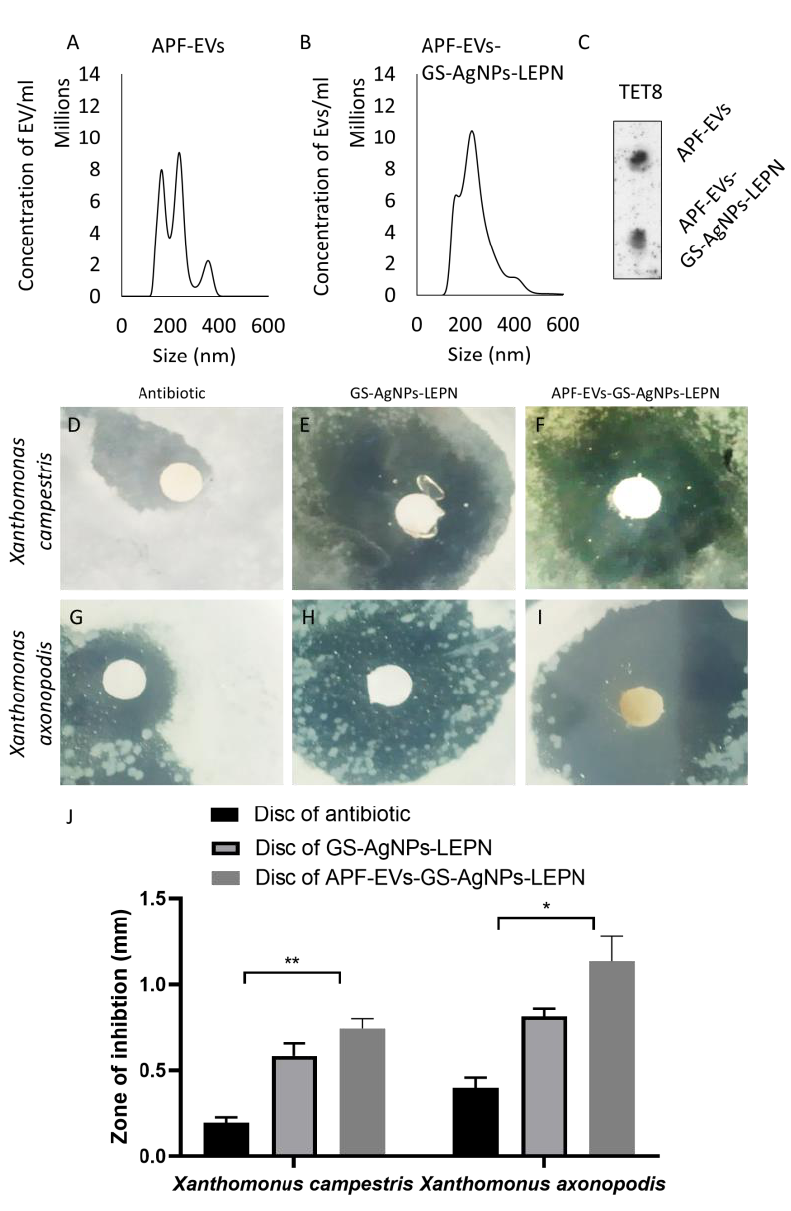
Figure 6. Comparing the antimicrobial activity of APF-EV-GS-AgNP-LEPN and GS-AgNP-LEPN against two different Xanthomonas species by a disc diffusion test. Representative ( A , B ) size distribution and ( C ) immunoblot showing the expression of TET8 in protein samples of APF-EV and APF-EV-GS-AgNP-LEPN. Representative zone of inhibition of Ampicillin, GS-AgNP-LEPN, and APF-EV-GS-AgNP-LEPN against ( D – F ) Xanthomonas campestris and ( G – I ) Xanthomonas axonopodis pv. ( J ) Representative bar graph showing the zone of inhibition by Ampicillin and GS-AgNP-LEPN. Data in ( J ) are presented as the mean ± SEM (N = 3). Disc of antibiotic vs. Disc of GS-AgNP-LEPN, Disc of antibiotic vs. Disc of APF-EV-GS-AgNP-LEPN; * p < 0.05 and ** p < 0.01.